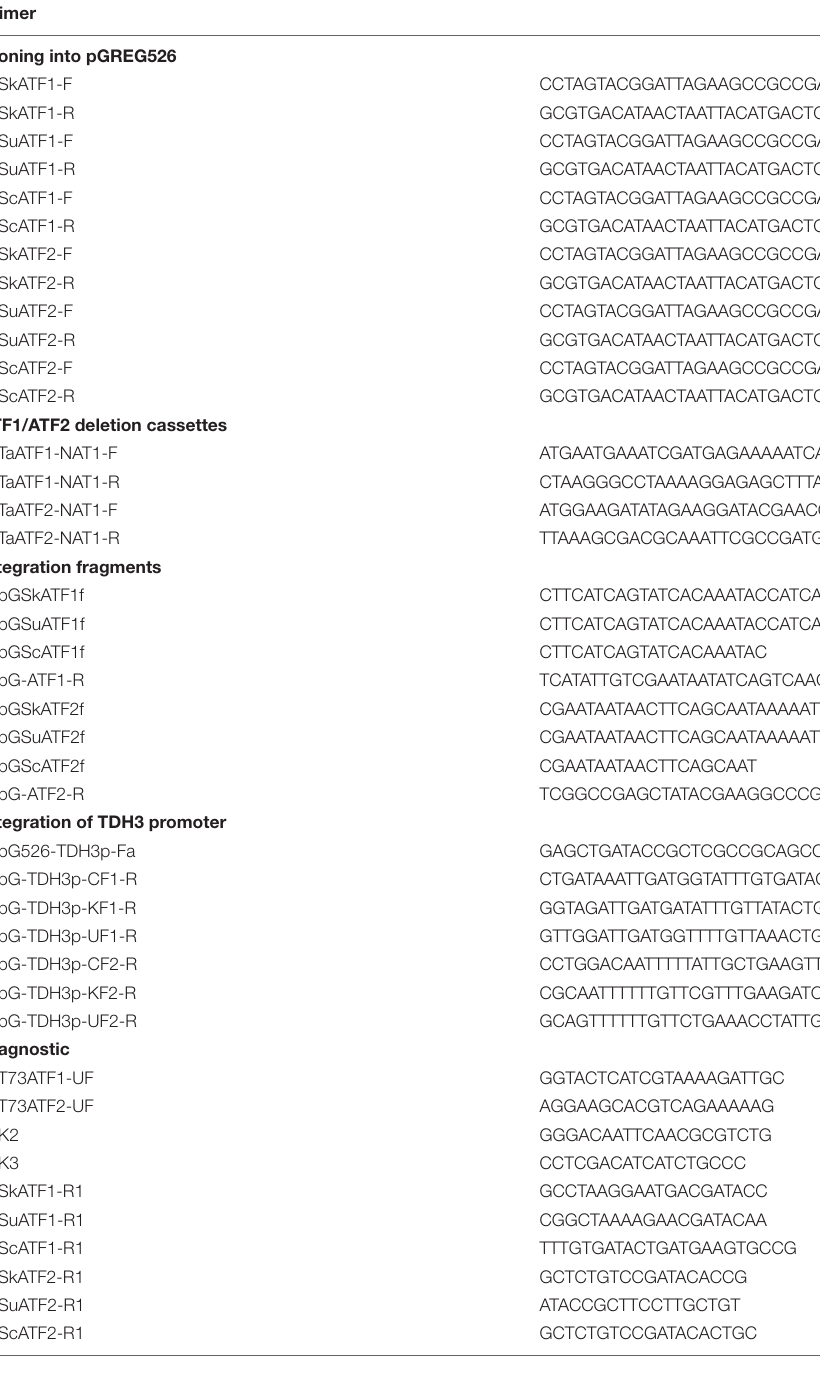
TABLE 2 | The primers used in this